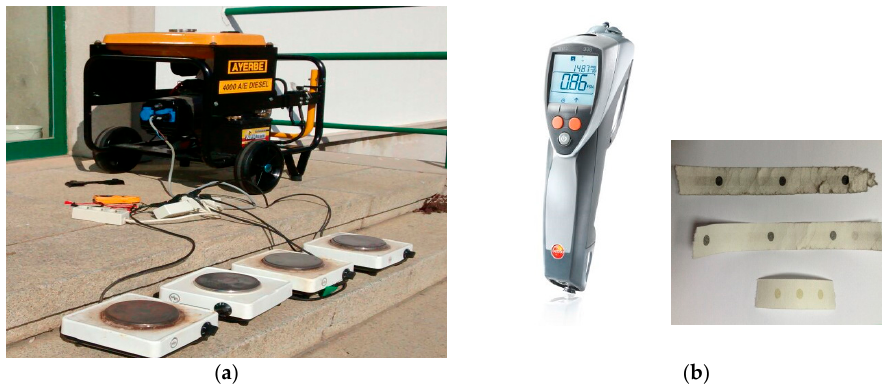
Figure 1. Electrogenerator AYERBE, 5KVA, 230v tipo AY4000MN, heating plates of 1000 watts of power each and voltmeter-ammeter devise (yellow color, on the floor) ( a ); TESTO 308 opacity meter, which from Burning Distillate Fuels ( b ).